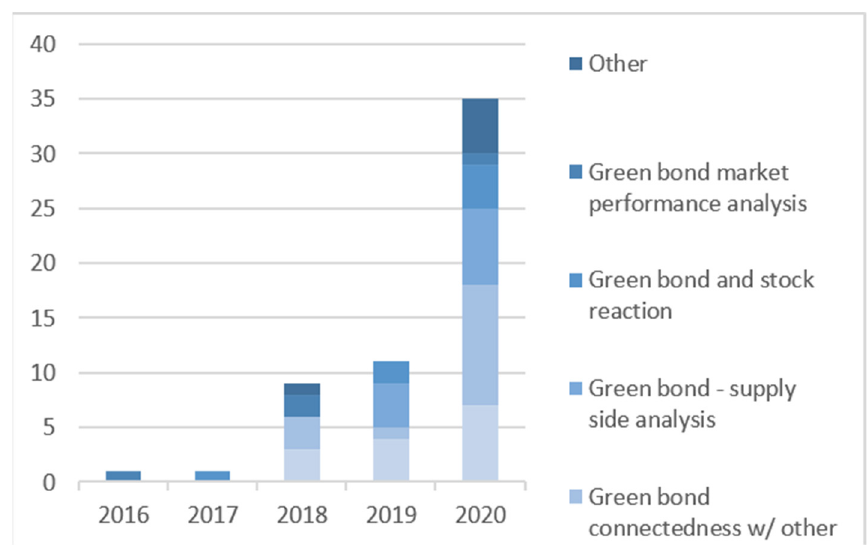
Figure 5. Research trends within taxonomy.